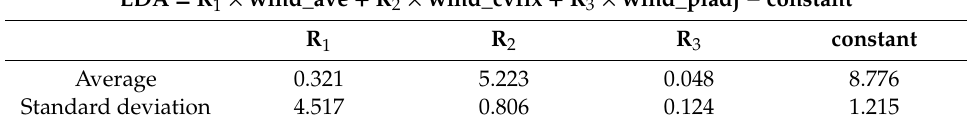
Figure 1. ( a ) Hit rate (HR), ( b ) false alarm rate (FAR), and ( c ) the Peirce skill score (PSS) compared for different selections of potential predictors in the Linear Discriminant Analysis (LDA) model. Each gray dot shows the performance of a different combinations of predictors and the black dot represents the highest performance in terms of PSS. Table 2. Average and standard deviation of coefficients in the linear discriminant analysis equation using for training sample datasets.